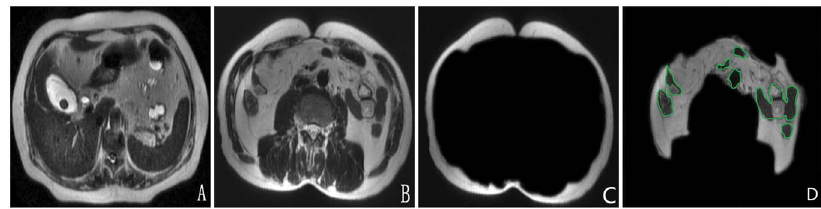
Figure 1. A 52-year-old male with gallbladder stone. One stone can be found in neck of gallbladder (A) and navel level image was found by a localizer sequence (B). SAT is to be the area between outline of abdominal skin and the outer abdominal muscle (C). VAT is to be enterocoelia and retroperitoneal region between the inside edge of abdominal muscles and the spinal front. Intestines and big vessels that have been circled by green line are not included in the intra-abdominal fat area (D). Axial fast-recovery fast spin-echo T2-weighted images without fat suppression shows intra- abdominal fat with SAT=96.21 cm 2 and VAT=104.05 cm 2 .